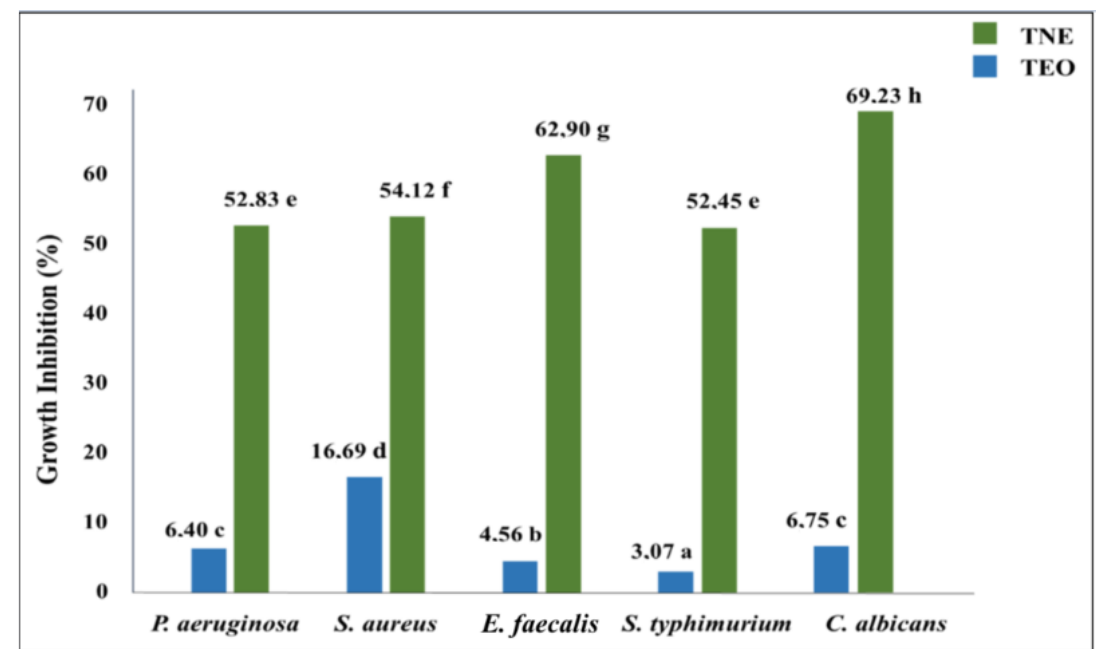
Figure 4. Microbial growth inhibition (expressed in %) induced by bulk (TEO) and nanoencapsulated (TNE) T. capitatus EO (33 mg/mL) against five microbial strains. Values followed by different letters mean statistically significant differences ( p < 0.01).